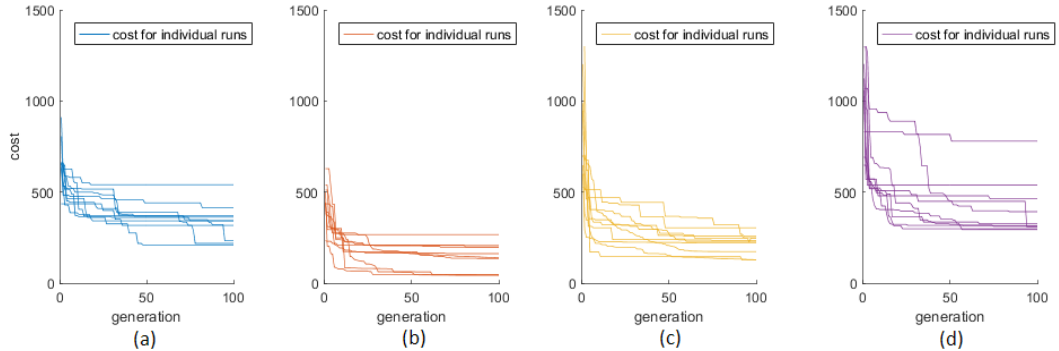
Figure 11. All runs for trajectory task 1 and cost function cost 1 : with ( a ) basic links; ( b ) linear links; ( c ) rounded links; ( d ) Hermite spline links.